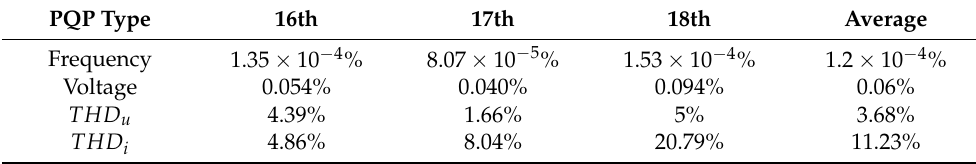
Table 11. Forecasting error (MAPE in%) for 16–18 August 2021, when using the boosting